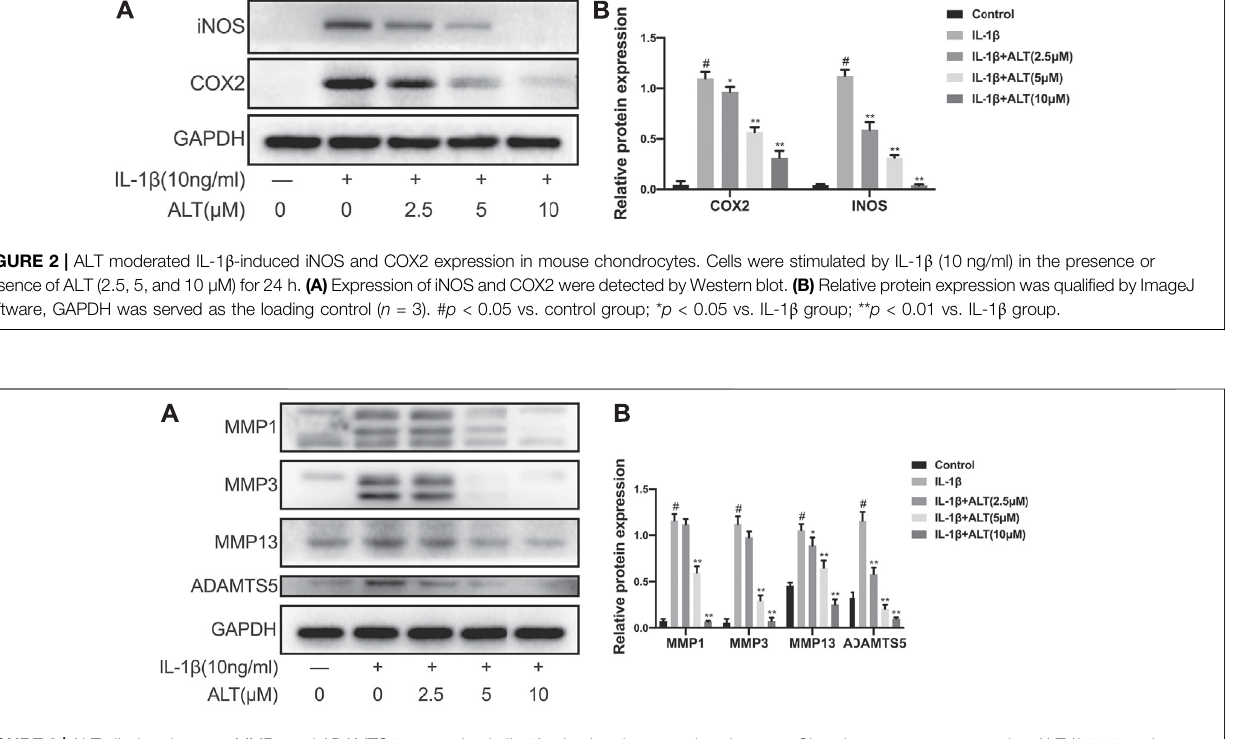
FIGURE 3 | ALT alleviated excess MMPs and ADAMTS5 expression in IL-1 β -stimulated mouse chondrocytes. Chondrocytes were exposed to ALT (2.5, 5, and 10 μ M) with or without IL-1 β (10 ng/ml) for 24 h. (A) Western blot was employed to determine the expression of MMP1, MMP3, MMP13, and ADAMTS5. (B) Relative protein expression was quali fi ed by ImageJ software, GAPDH was used as the internal control ( n (cid:2) 3). # p < 0.05 vs. control group; * p < 0.05 vs. IL-1 β group; ** p < 0.01 vs. IL-1 β